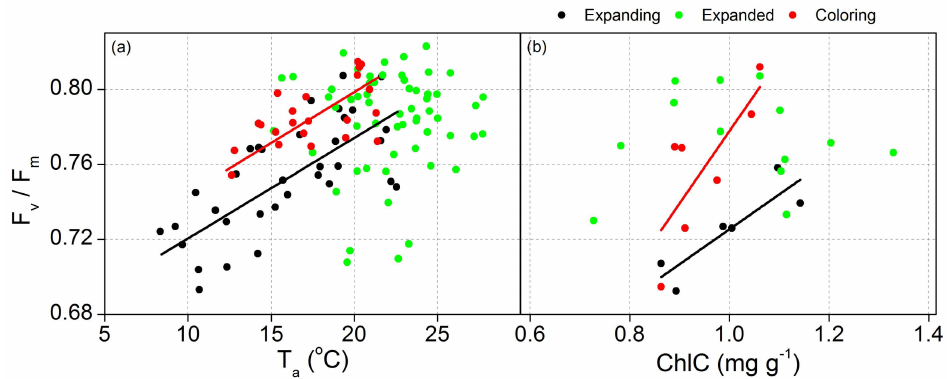
Figure 3. Relationship between maximal quantum yield of PSII photochemistry (F v /F m ) and daily mean air temperature (T a , ( a )), and the sum content of chlorophyll a and chlorophyll b (ChlC, ( b )) during each phenophase for the 2014 growing season. Black, green, and red colored circles and lines coincide with values and fitting functions (Table 1) for the leaf-expanding, expanded, and coloring phases, respectively. Data from rainy days were excluded from the analysis. Table 1. Regression equations between meteorological variables and ChlF-associated parameters during the growing season (DOY 102 to 285) of 2014. Independent variables include daily mean incident photosynthetically active radiation (PAR), air temperature (T a ), relative humidity (RH), atmospheric vapor pressure deficit (VPD), sum content of chlorophyll a and chlorophyll b (ChlC), and ratio of chlorophyll a to chlorophyll b (i.e., Chl a / b ). Dependent variables include maximal quantum yield of PSII photochemistry (F v /F m ), daily mean effective quantum yield of PSII photochemistry ( Φ PSII ), Stern–Volmer non-photochemical fluorescence quenching (NPQ), and quantum yield of regulatory light-induced non-photochemical quenching ( Φ NPQ ). p -values represent significant level for the regression models. r 2 is the coefficient of